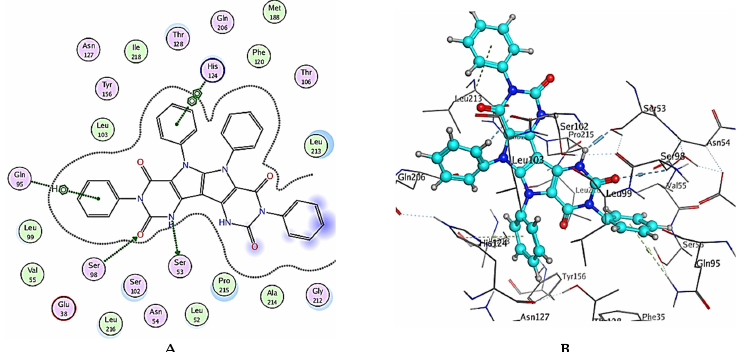
Figure 8. ( A ) Two-dimensional interactions and ( B ) three-dimensional interactions of compound 5 fitted into the binding site of NPC1L1 (pdb code: 3QNT) illustrating interactions with amino acid residues in the binding site. Molecules 2022 , 27 , x FOR PEER REVIEW 12 of 23